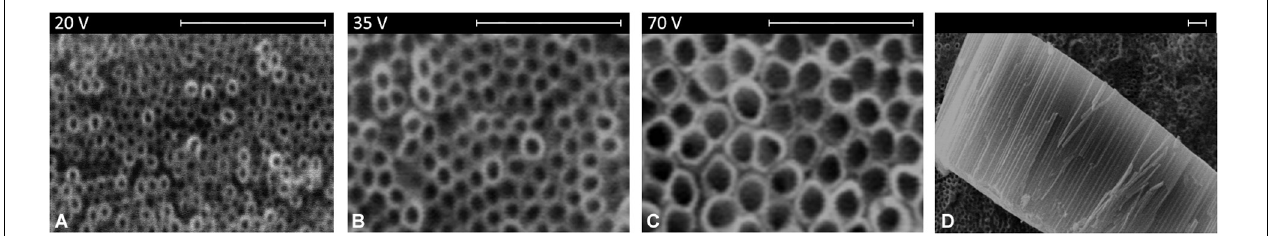
FIGURE 2 | Surface morphology of nanotubes’ array obtained at different voltages (A–C) and section view (D) . Scale bar = 1 µ m.